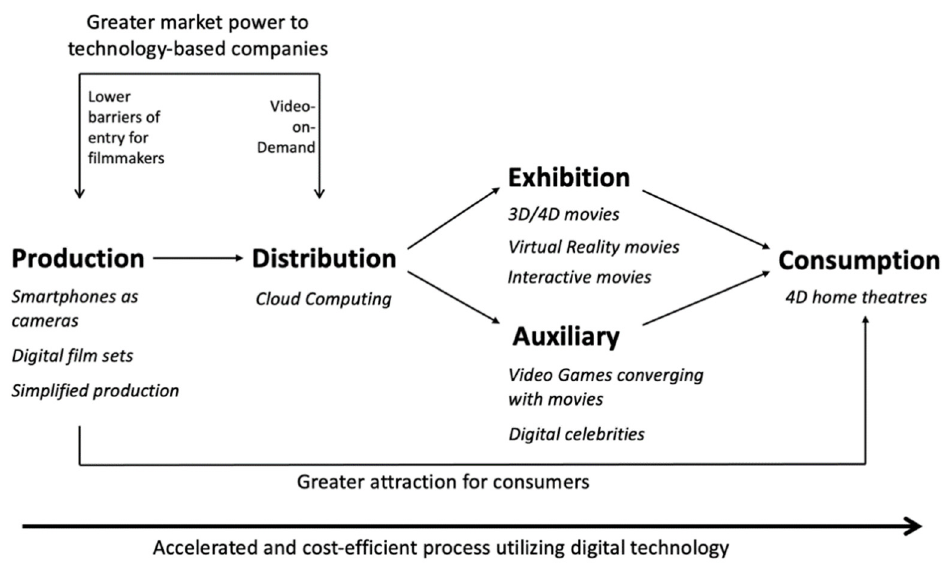
Figure 4. Conceptual framework. Source: own elaboration.